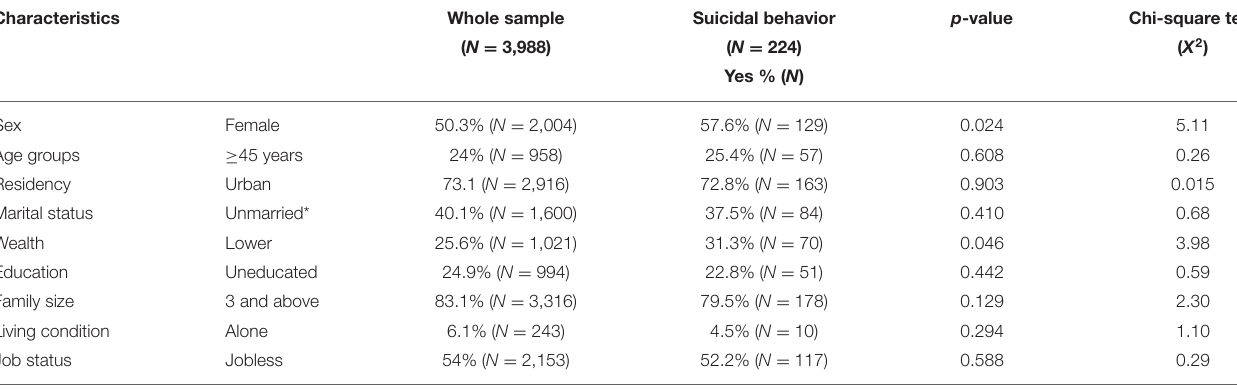
TABLE 1 | Bivariate comparison of participants’ sociodemographic characteristics in relation to having YES or NO suicidal behaviors. Characteristics